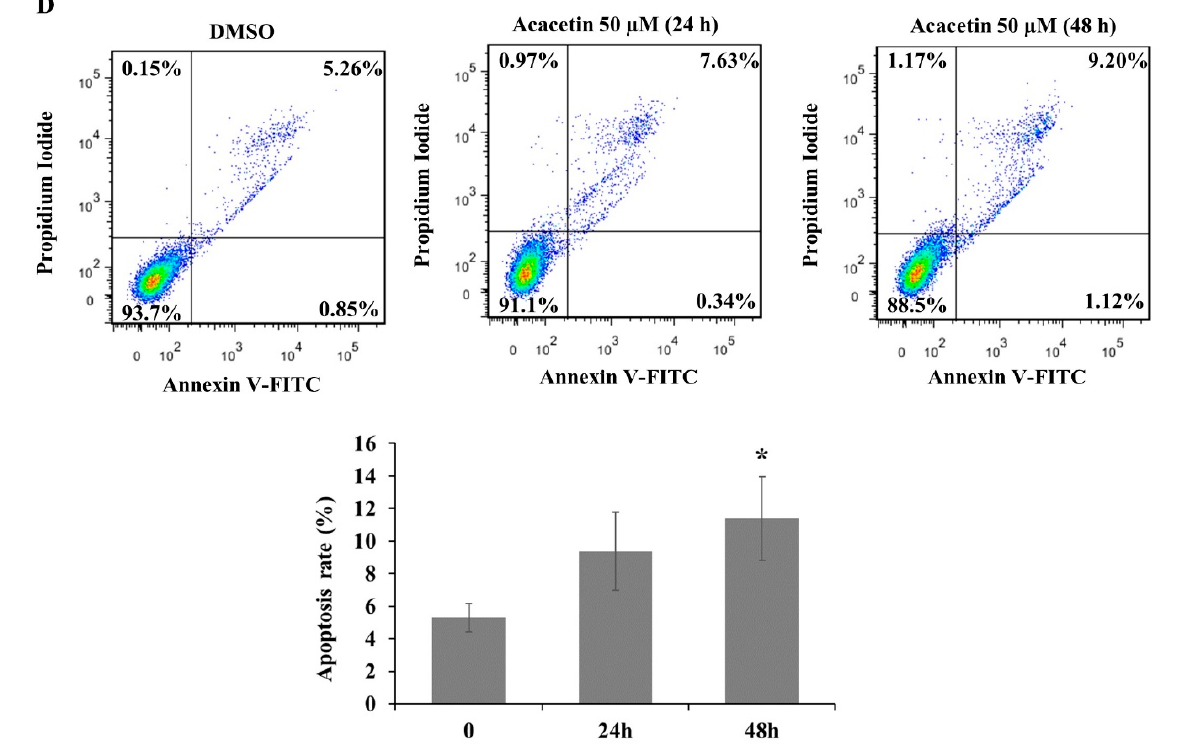
Figure 2. Acacetin inhibits the translocation of STAT3 into the nucleus and downregulates the expression of STAT3 target genes that induce apoptosis. ( A ) DU145 cells were treated with acacetin (50 µ M) for 24 h. The nuclear localization of STAT3 was analyzed by immunocytochemistry using STAT3 antibody (green). Scale bars, 20 µ m. ( B ) DU145 cells were treated with acacetin (50 µ M) for 24 h, and the expression level of STAT3 target genes was analyzed by Western blotting. The band intensity of each protein was quantified using the MultiGauge program. ( C ) DU145 cells were treated with acacetin (50 µ M) for the indicated times. After treatment, the cell cycle distribution was analyzed using a FACSCalibur flow cytometer. The ratios of cells in each phase were analyzed using the WinMDI 2.9 analyzer. ( D ) DU145 cells were treated with acacetin for 24 or 48 h and dual-stained with annexin V-FITC and propidium iodide. Apoptotic cell death was detected by flow cytometry. The data represent the means ± s.d.; comparisons were performed with t-tests; * p < 0.05.